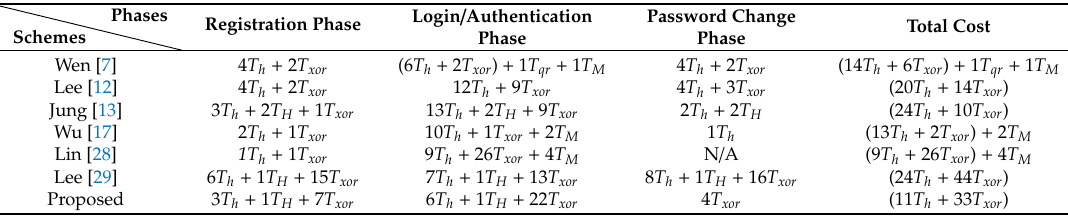
Table 2. Performance comparison